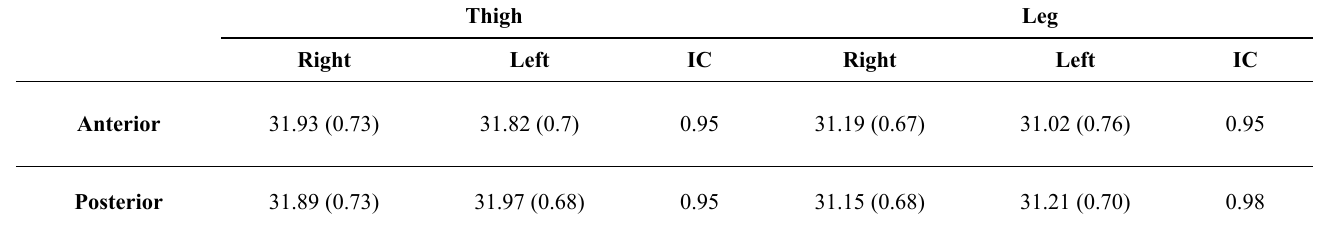
(regions of interest) and A B